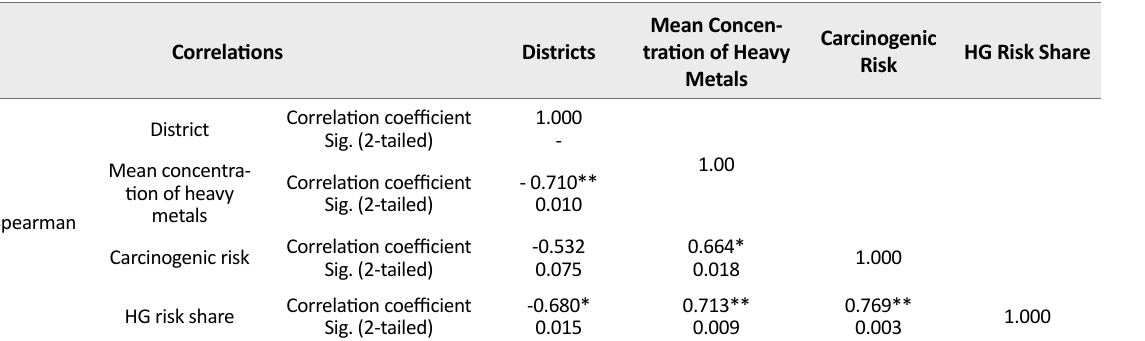
districts (2, 3, and 15) of Tehran Metropolis, Winter 2018